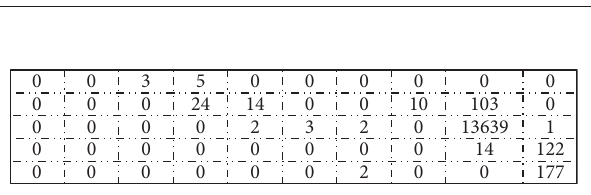
sample networks, the 𝑥 -values are obtained. The condition for added units in the sample is defined by 𝐶 = {𝑦 : 𝑦 > 0}